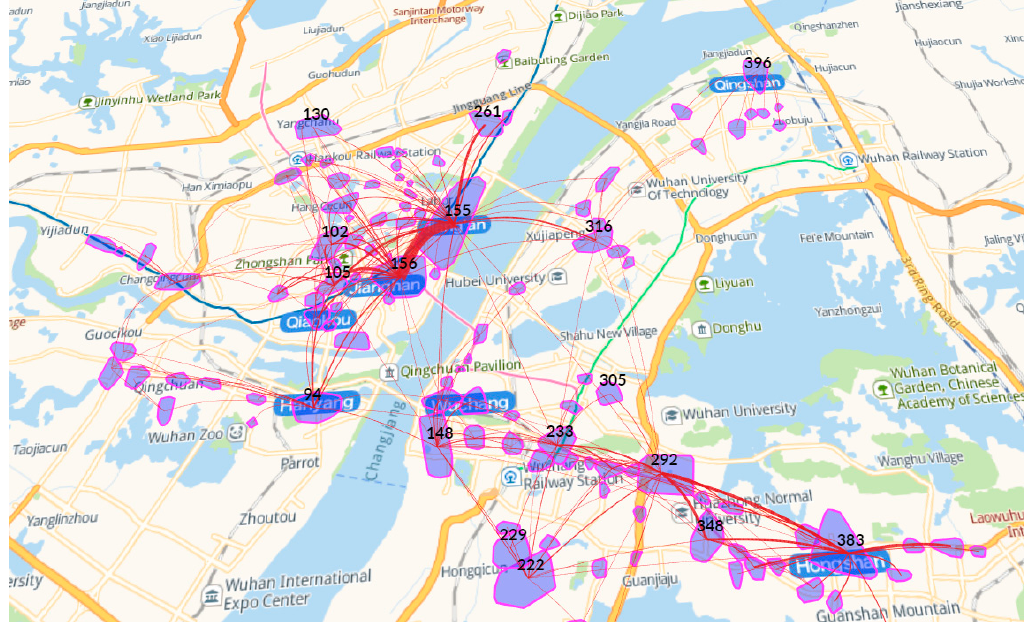
Figure 6. The overall view of urban mobility in Wuhan.